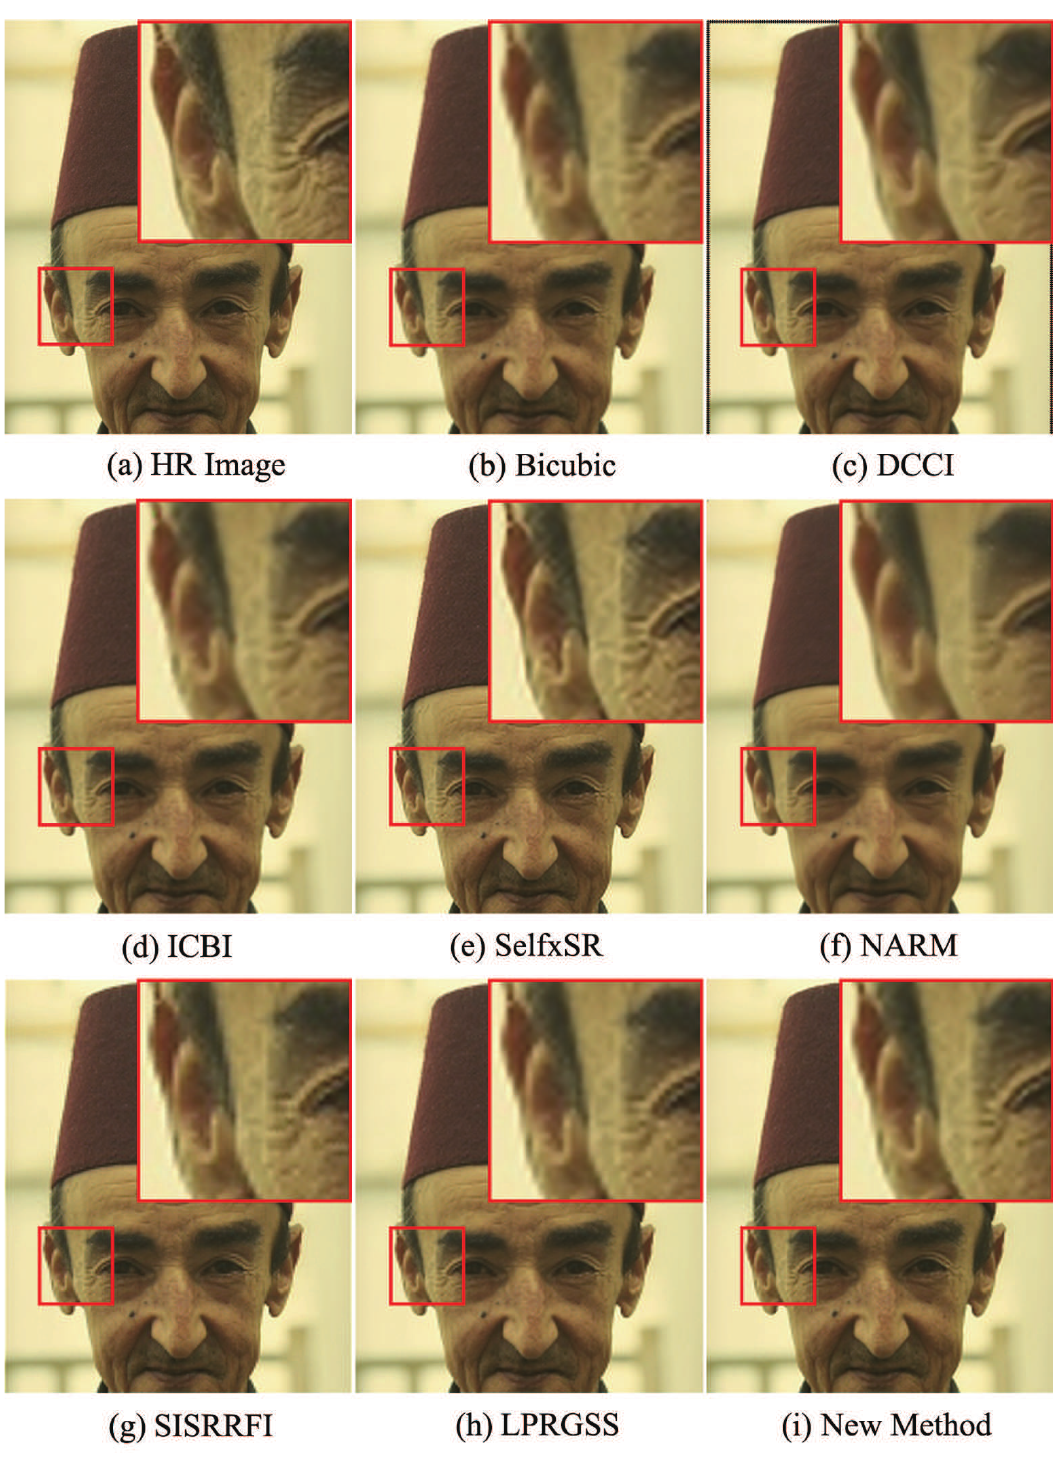
Figure 7. Elderly images magnified by eight